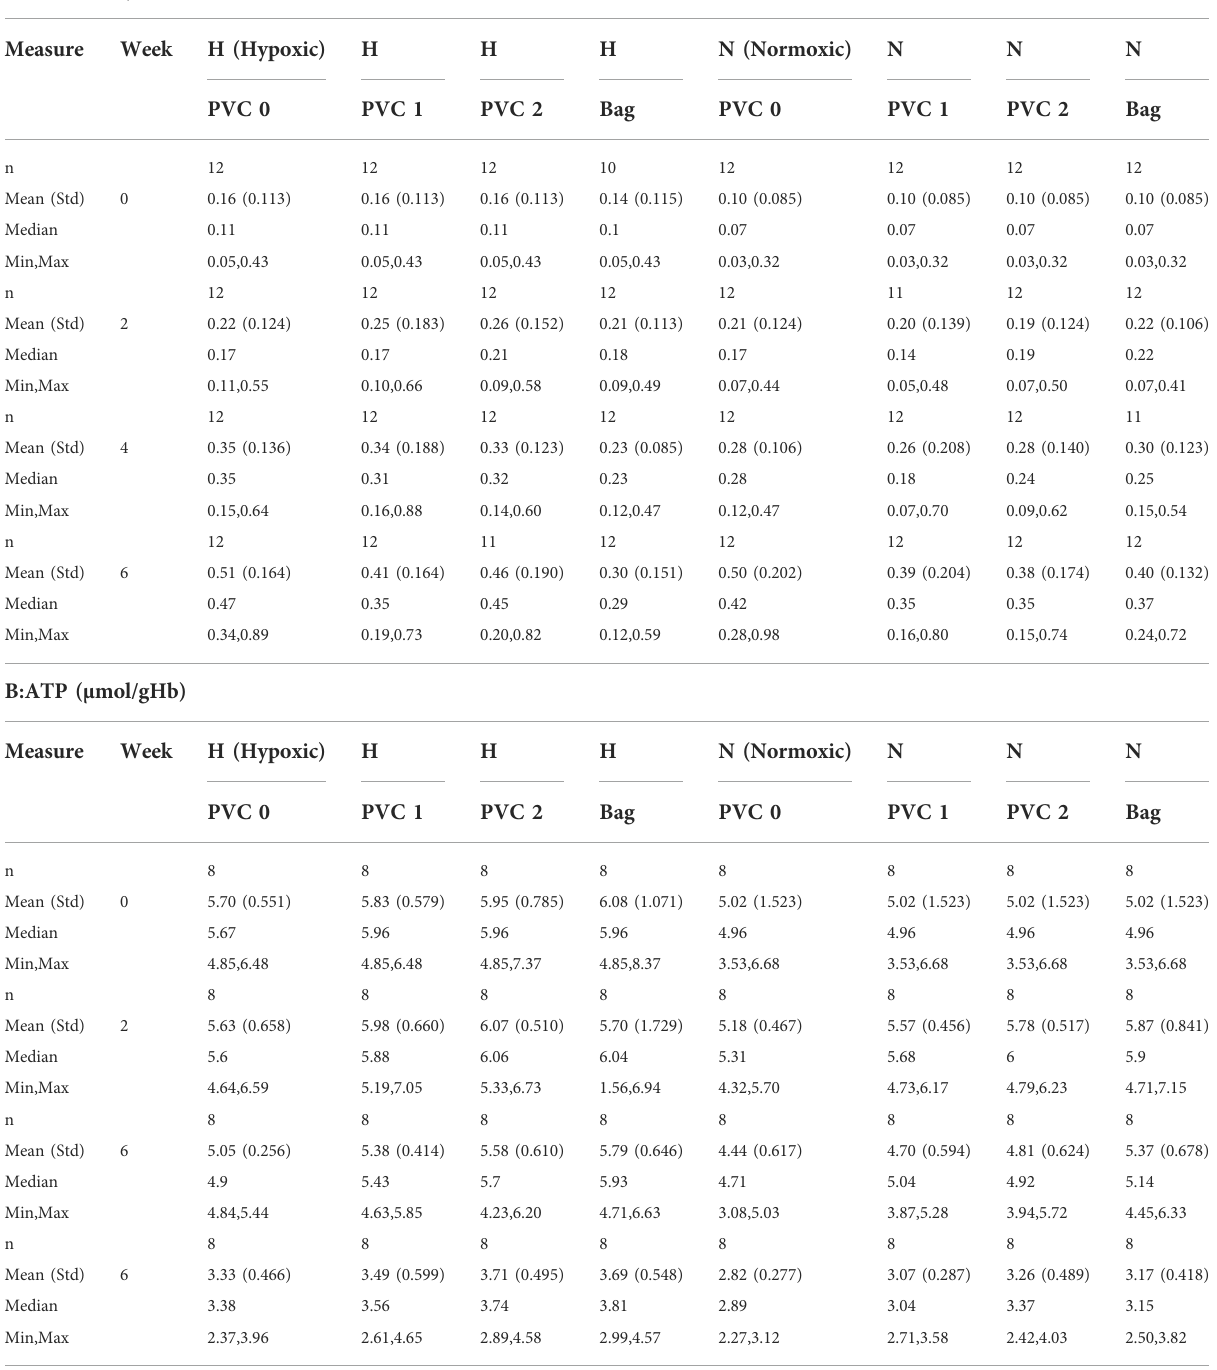
TABLE 1 Descriptic statistics for ATP and